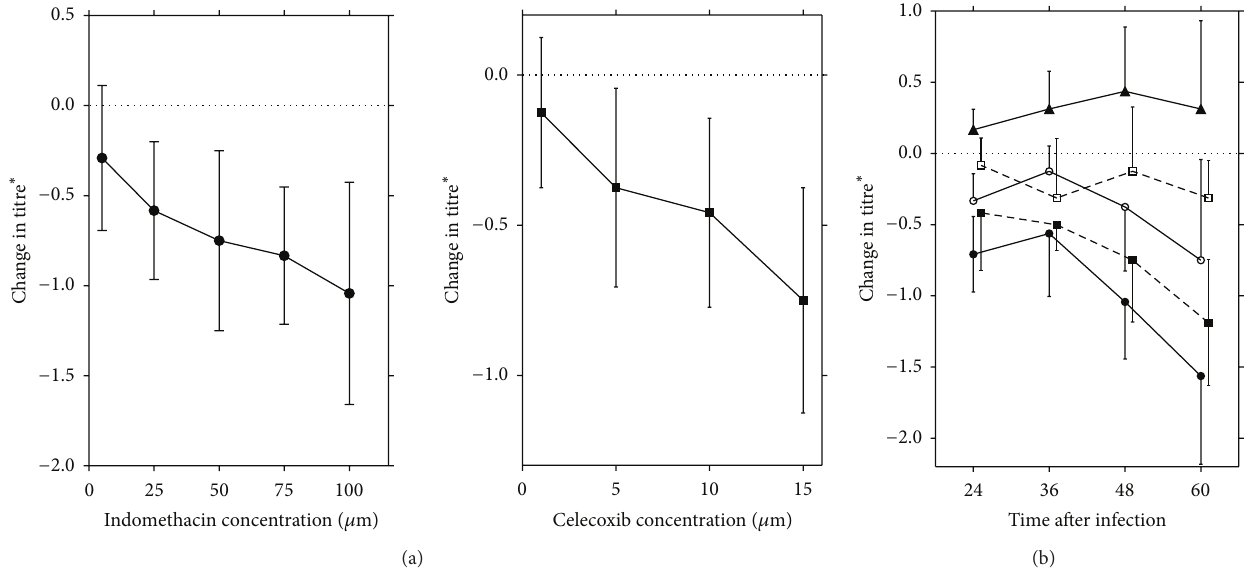
Figure 4: The effects of inhibitors of prostaglandin synthesis and PGE 2 on the yields of HSV-1 in VGN cultures. (a) The cultures were collected and titrated at 48 hpi. (b) e , 100 𝜇 mol/L indomethacin; I , 100 𝜇 mol/L indomethacin + 15 𝜇 mol/L PGE 2 ; 󳵳 , 15 𝜇 mol/L PGE 2 ; ◼ , 15 𝜇 mol/L celecoxib; ◻ 15 𝜇 mol/L celecoxib + 15 𝜇 mol/L PGE 2 . ∗ Log geometric mean TCID50 with drug minus log geometric mean TCID50 without